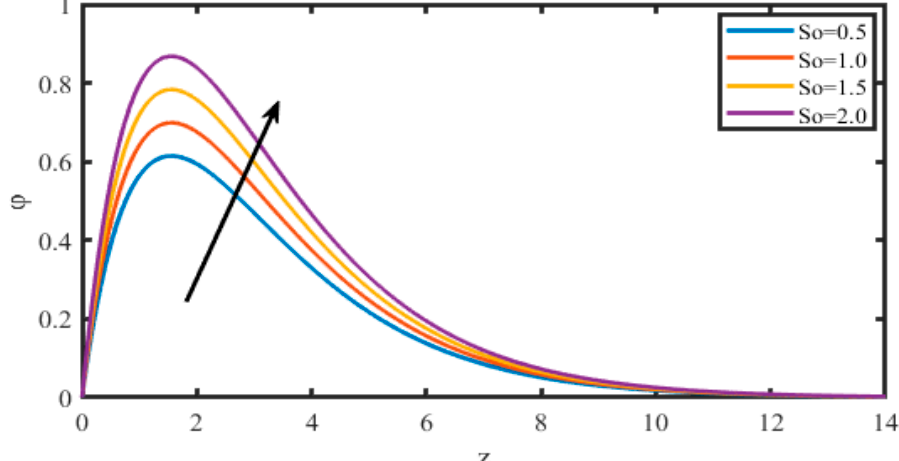
Figure 14. The influence of the Soret parameter So on the Concentration profiles.